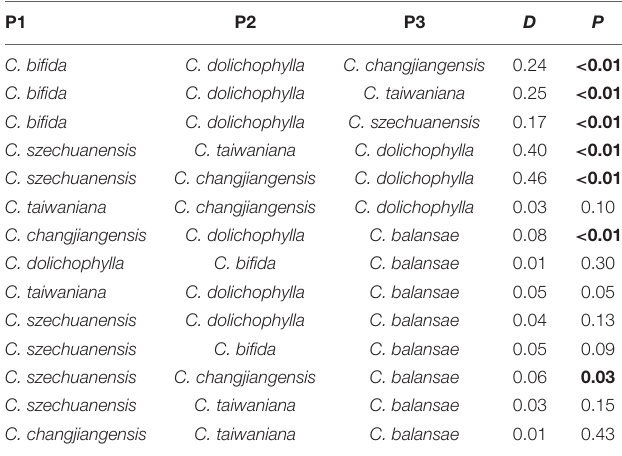
TABLE 3 | ABBA-BABA analysis in the six species of Cycas .